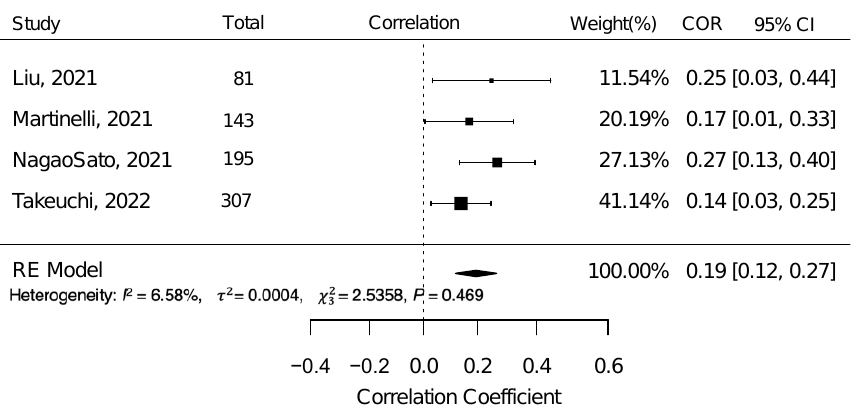
Figure 4. Risk of publication bias assessment for the four studies included in the meta-analysis – Liu et al. (2021) [50], Martinelli et al. (2021) [51], Nagao Sato et al. (2021) [52], and Takeuchi et al. (2022) [53], to examine the correlation between reflection spectroscopy-assessed skin carotenoid score with fruit and vegetable consumption in children. 3.6. Risk and Bias Assessment Risk and bias assessment using the NHLBI tool [54] for the three intervention studies indicated that two had moderate risk of bias and another had high risk of bias. Not